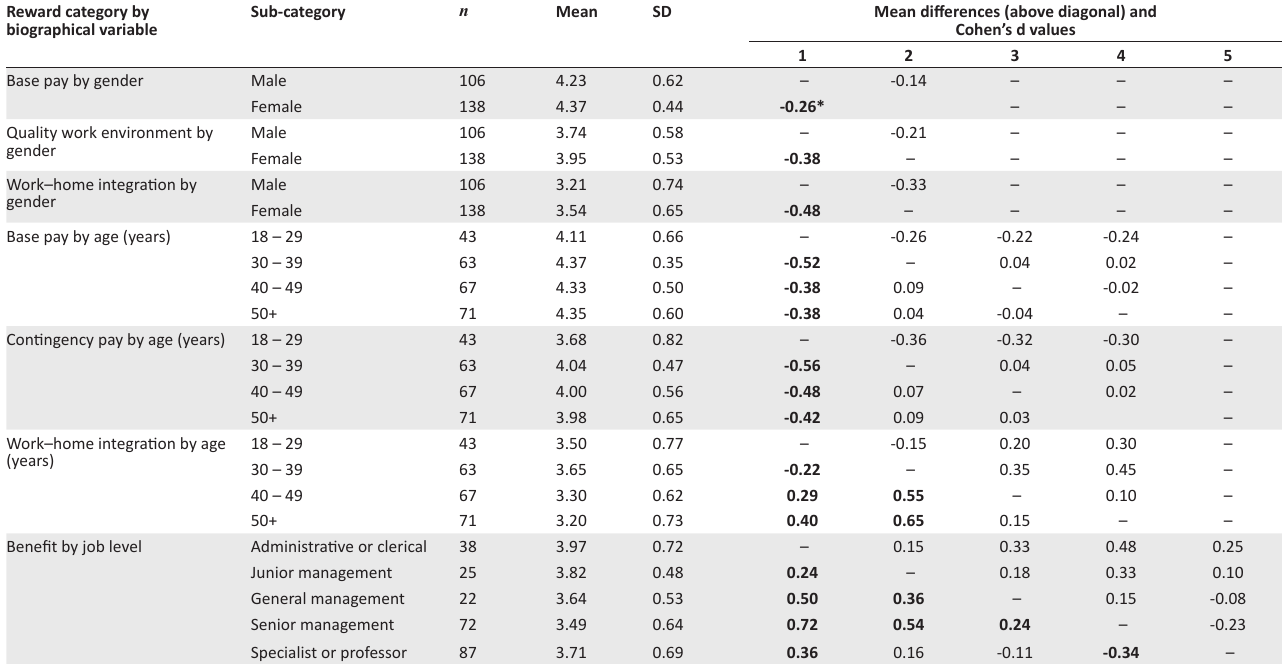
TABLE 7: Statistics for factors related to biographical variables. Reward category by biographical variable